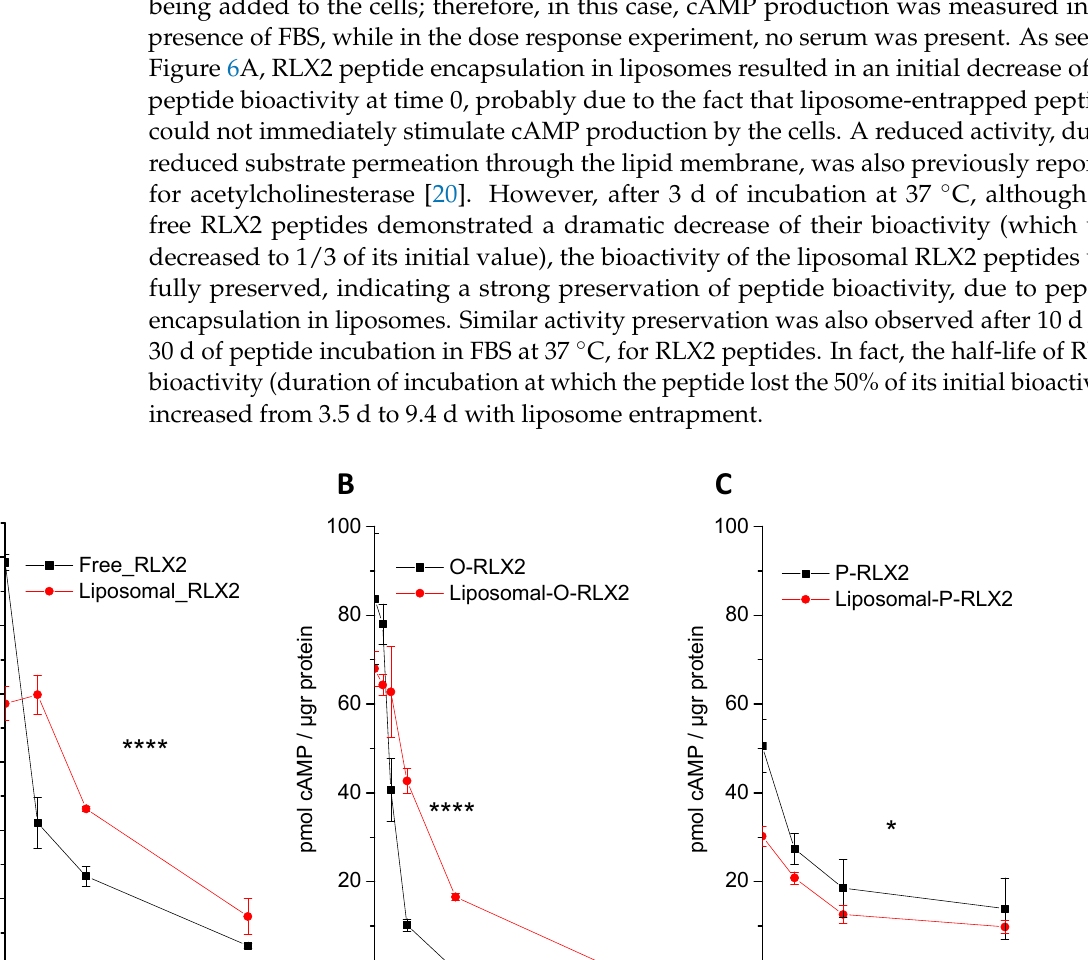
with free and liposomal RLX2 peptides that were incubated for various durations in FBS (80% v / v ) at